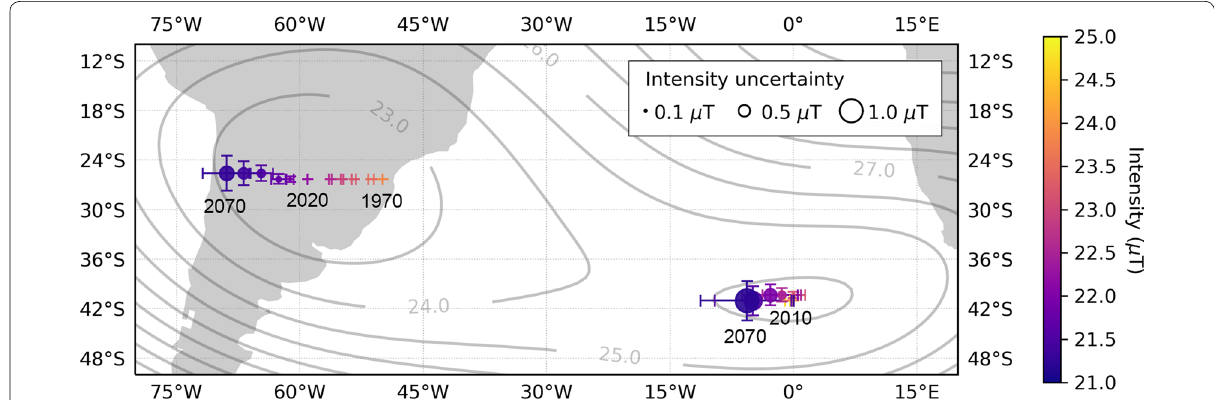
Fig. 10 Evolution of the South Atlantic Anomaly (SAA) over the period 1970–2070 calculated from the ensemble assimilation (note that after 2020 only the forecast is shown, while before only the analyses are displayed). The background contour lines represent the field intensity based on the mean analysis in 2020 and the symbols correspond to the position and intensity (color scale) of the two minima every 10 years. The error bars correspond to the 1 σ uncertainty in latitude and longitude, while the symbol size scales with the uncertainty in the intensity of each minimum point in